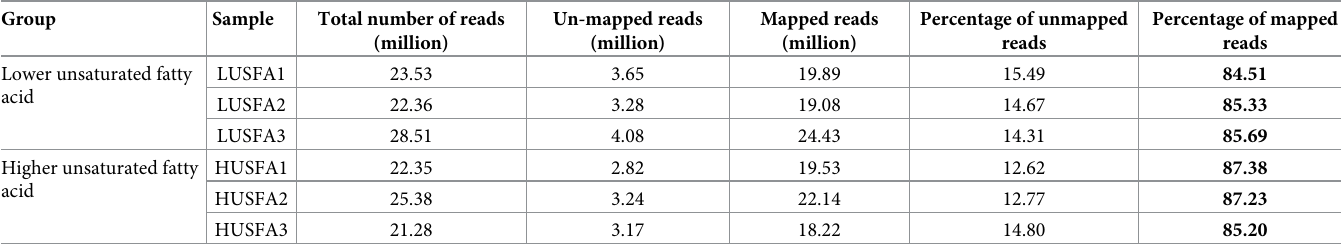
Table 2. Summary of sequence read alignments to reference genome in liver samples. Group